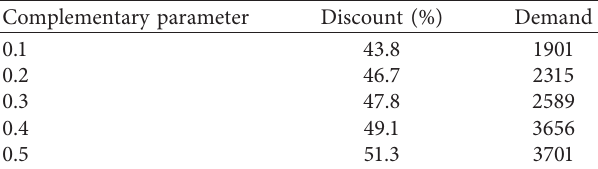
Table 9: Impact of the complementarity degree. Complementary